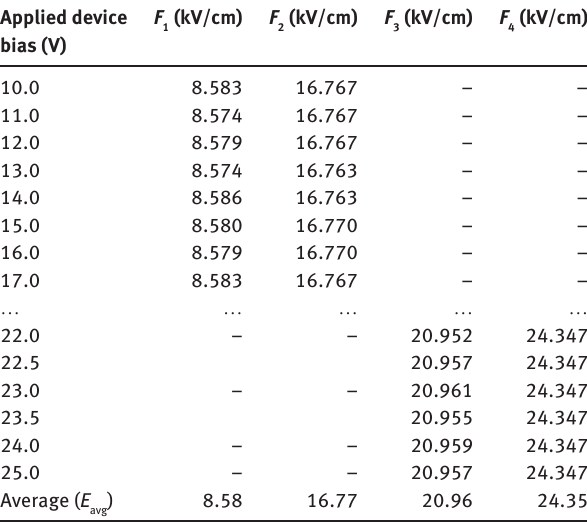
Table 3: SVM-measured electric field in each observed